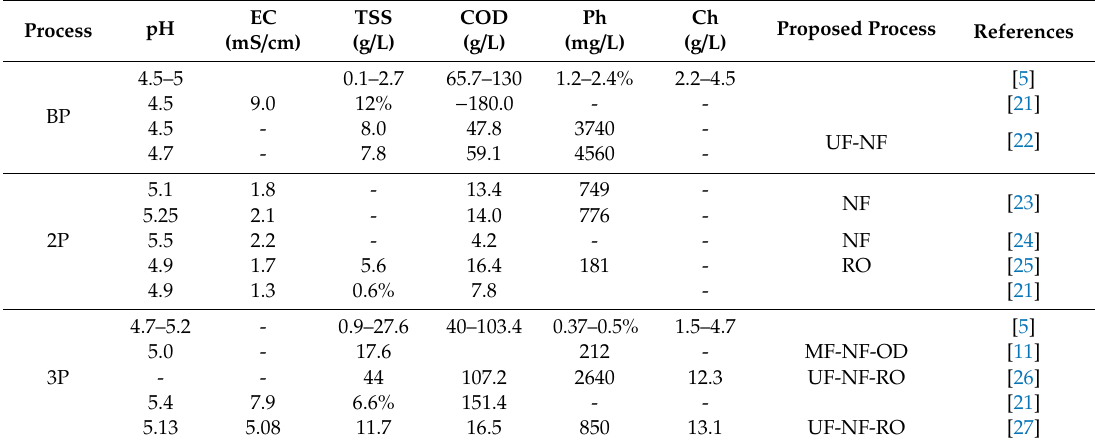
Table 1. Analytical characteristics of olive mill wastewater (OMWs) from the batch (BP), two-phase (2P) and three-phase (3P) processes and some integrated membrane processes proposed in literature. EC TSS COD Ph Ch Proposed Process References Process pH (mS / cm) (g / L) (g / L) (mg / L) (g /